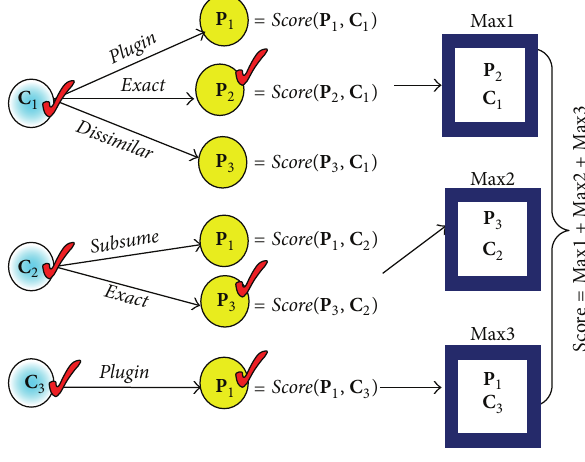
Figure 4: A simple example using Algorithm